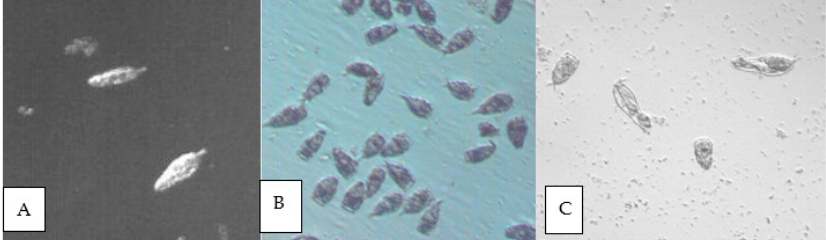
Figure 8. Effect of tryptic soy broth (TSB), bacterial ( Bacillus and S. maltophilia ) supernatant, and bacterial lysates obtained after treatment of bacterial cultures with mitomycin C (+M), on rotifer motility; observations performed up to 24 h. Statistical significance was tested by the one-way analysis of variance (ANOVA) followed by the Tuckey post-hoc test at p ≤ 0.05 (N = 5); points topped by the same letter (a, b or c) do not differ significantly.